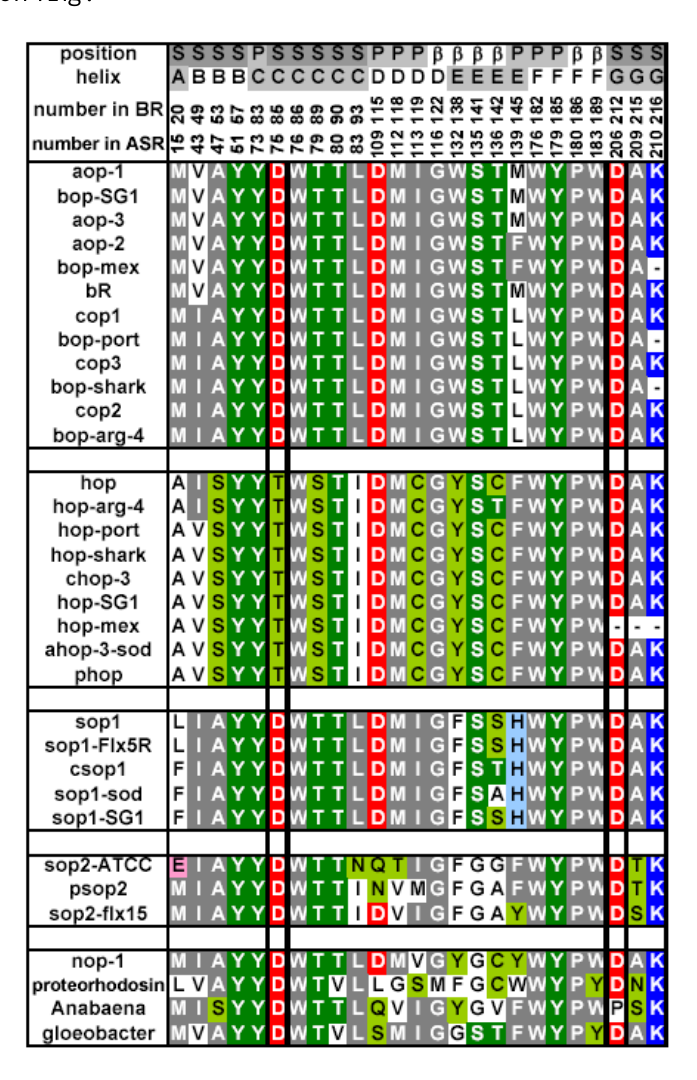
second, third, fourth and fifth categories represent the families of bacteriorhodopsin, halorhodopsin, sensory rhodopsin I, sensory rhodopsin II and other archaeal-type rhodopsins, respectively. position S: near the Schiff base, P: near the polyene chain,  : around the  -ionon